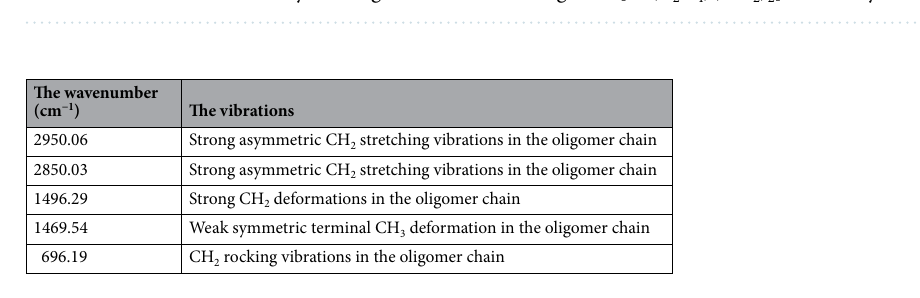
Table 4. IR results for the ethylene oligomer obtained using cis-K[Cr(C 2 O 4 )(OH 2 ) 2 ] as a catalyst.